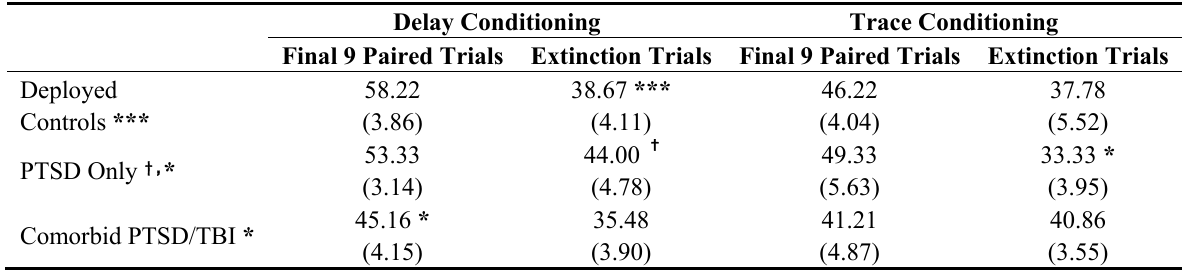
Table 6. Mean (and Standard Error) percent Conditioned responses for the final nine paired conditioning trials and nine extinction (tone alone) trials for delay and trace